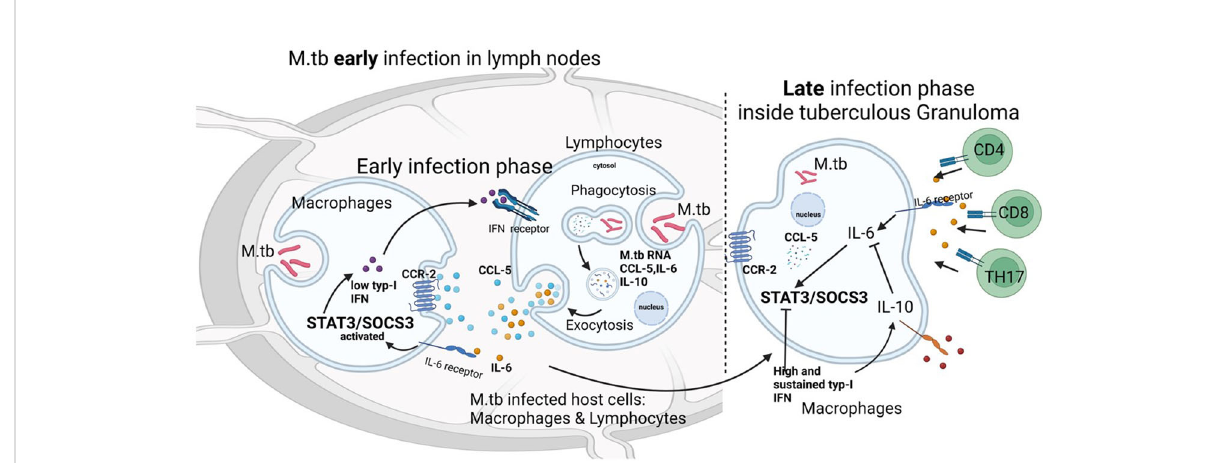
FIGURE 5 Relationship between the chemokine – ligand receptors IL-6 and IL-10 with STAT3 and SOCS3 in tuberculous lymphadenitis. In the early stages of infection, an increase in IL-6/IL-10 can also increase STAT-3 and SOCS-3, its regulator. This activation of STAT-3/SOCS-3 is related to an immunological response to TB infection. Chronic in fl ammation after TB infection reduces the function of T cells, especially T H 17 cells, and this explains the low STAT-3/SOCS-3 expression in this study. Another theory that may also explain that low STAT-3/SOCS-3 expression is due to high and sustained type I interferon (IFN) production in the late phase of TB infection. High IFN inhibits the activation of STAT-3 by